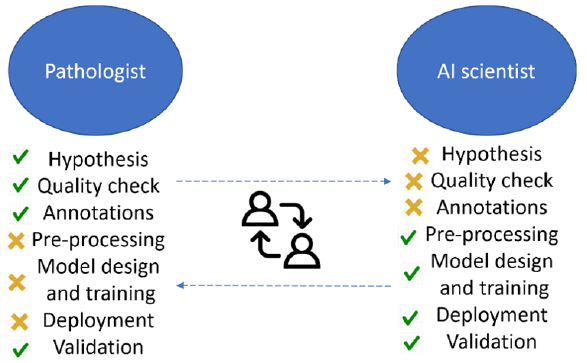
Figure 4. Tasks performed by pathologists and AI